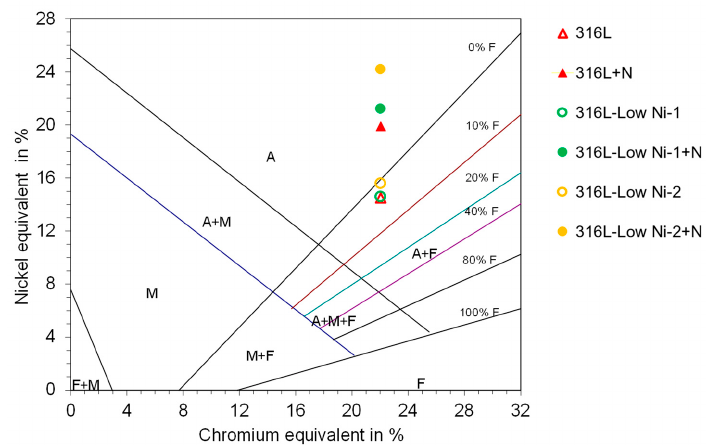
Figure 2. The position of the 316L steel and the modified 316L steels in Schaeffler diagram (A: F: ferrite, M: austenite, F: ferrite, M: martensite).